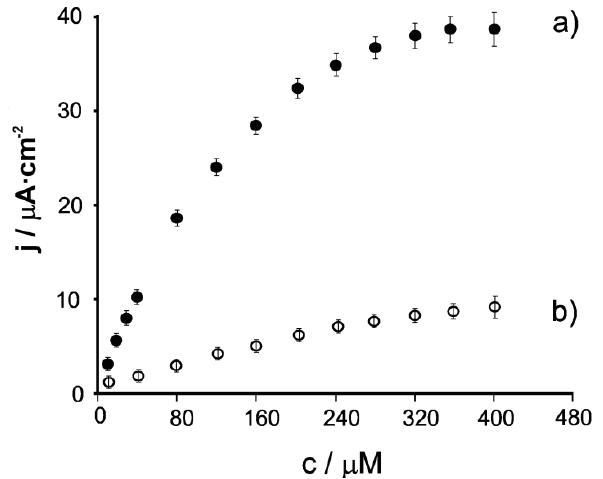
Figure 5. Calibration curve between the reduction current and the concentration of phenol